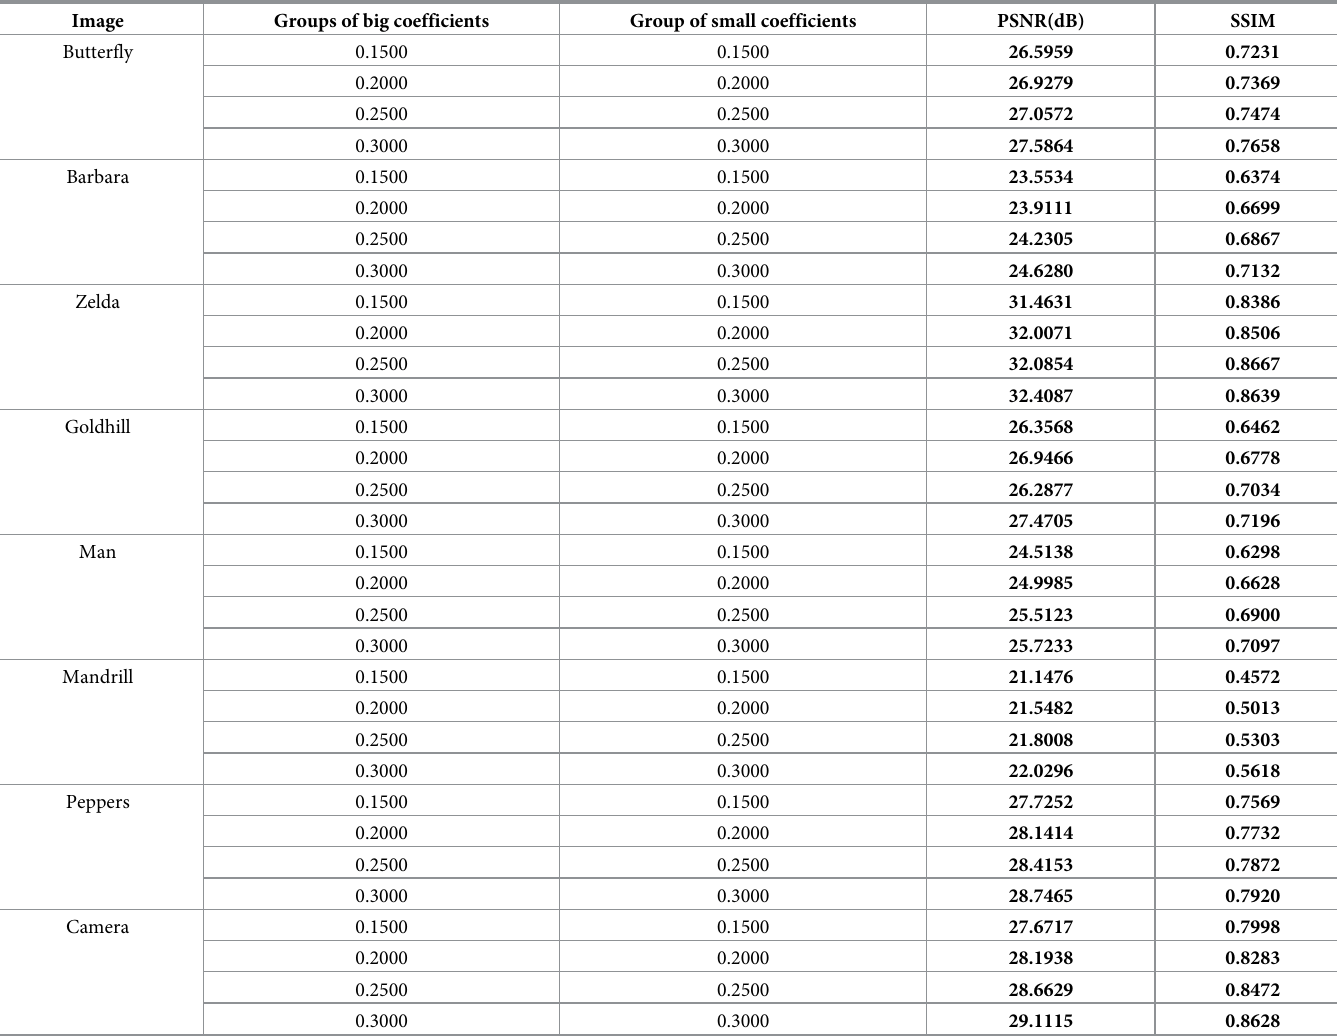
Table 2. Image compression results of SPIHT based on the contourlet-HMM–PCNN model on different bit rate (bpp).